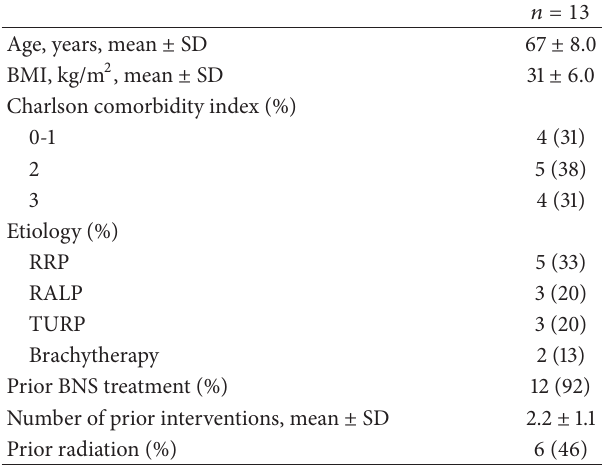
Table 1: Patient